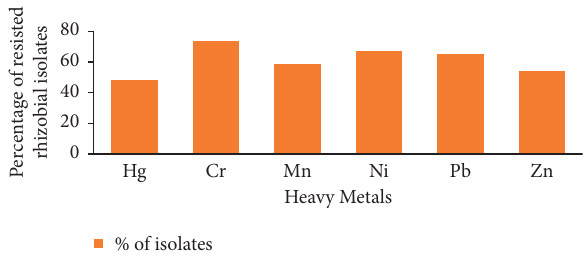
Figure 8: Heavy metal resistance of chickpea rhizobia isolates.